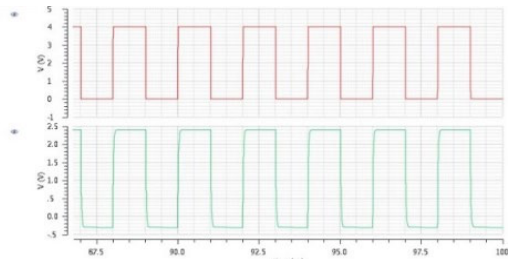
Figure 15. Schematic of switched capacitor converter using Transmission Gate.